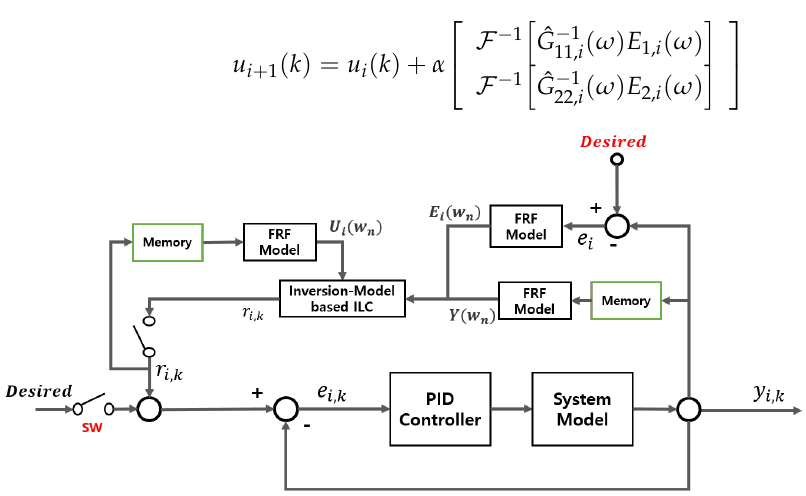
Figure 3. Block diagram for inversion-based